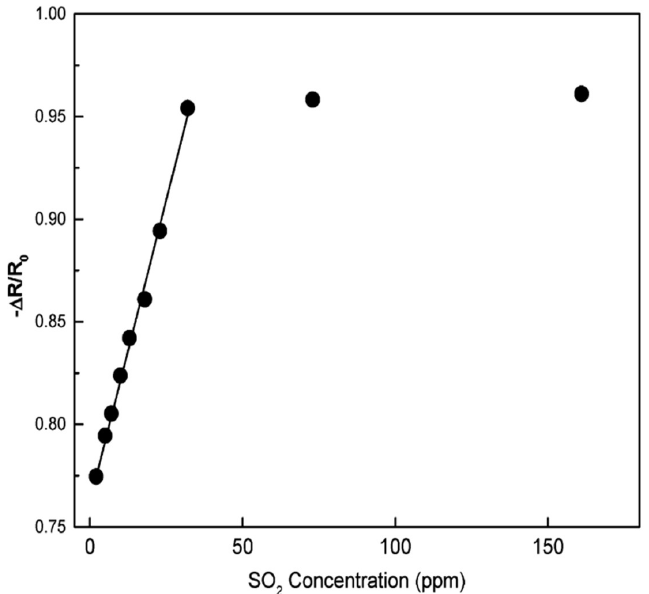
Figure 13. Calibration curve of SnO 2 -1 mol% Ni sensor for relating SO 2 content to the electrical response. SO 2 was diluted with dry N 2 to achieve the desired concentrations. The electrical responses were measured after 4.5 min of injection. (Reprinted with permission from [77]. Copyright 2005, American Chemical Society, Washington, DC,